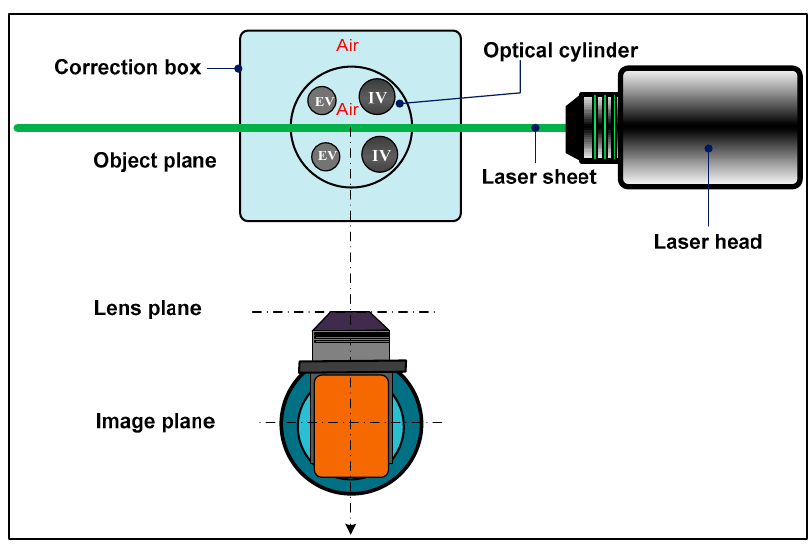
Figure 5. Top view of 2D-PIV camera configuration showing the correction box.